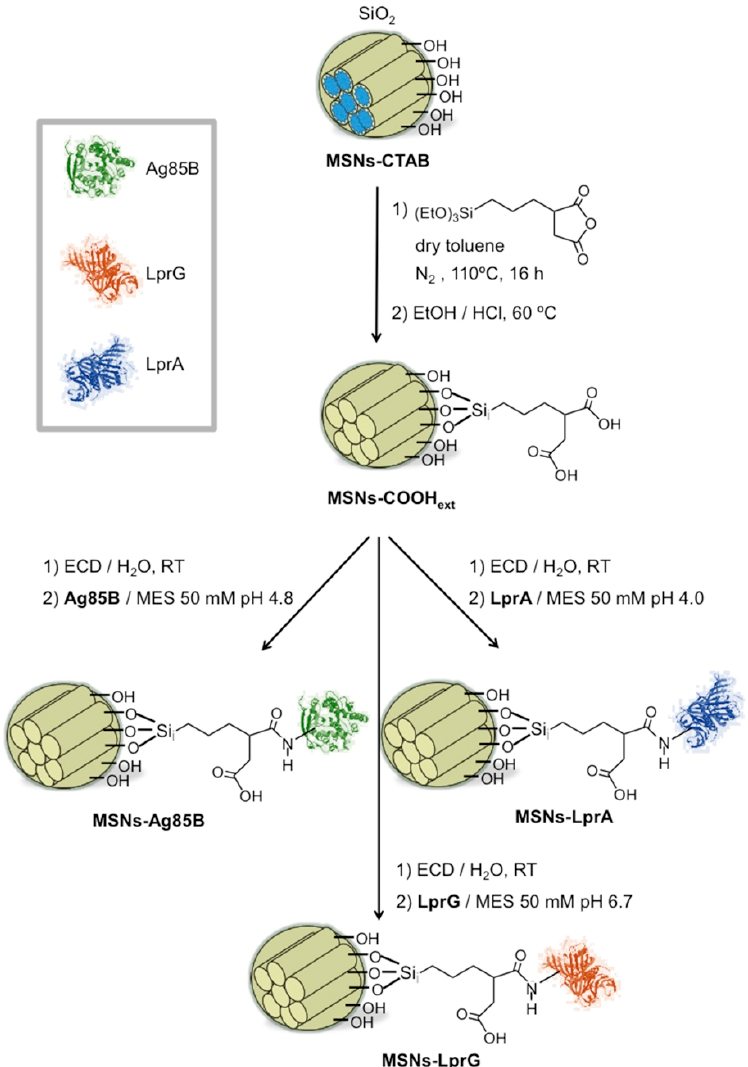
Figure 1. Scheme of synthesis of mesoporous silica nanoparticle (MSN) materials functionalized with the immunomodulatory proteins Ag85B, LprG, LprA.